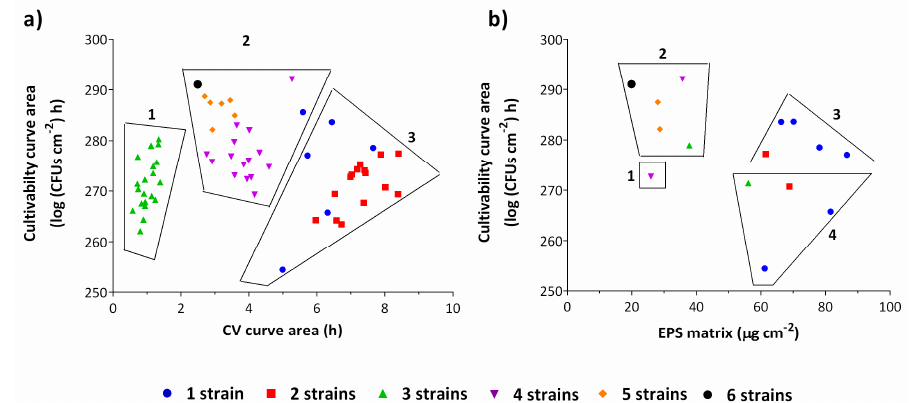
Figure 2. Cluster analysis for cultivability areas versus CV areas ( a ) and for cultivability areas versus EPS (extracellular polymeric substances) matrix ( b ) for 48 h-aged biofilms. Clusters are observable according to the number of strains in consortia. A trend for multi-strain biofilms to produce less EPS matrix is noticeable. The graph ( a ) is subdivided in three clusters: low cell numbers and biomass (1); high cell numbers and low biomass (2); low cell numbers and high biomass (3). The graph ( b ) is subdivided in four clusters: low cell numbers and EPS matrix (1); high cell numbers and low EPS matrix (2); high cell numbers and EPS matrix (3) and low cell numbers and high EPS matrix (4). The results represent three independent experiments. Results are presented as the mean.